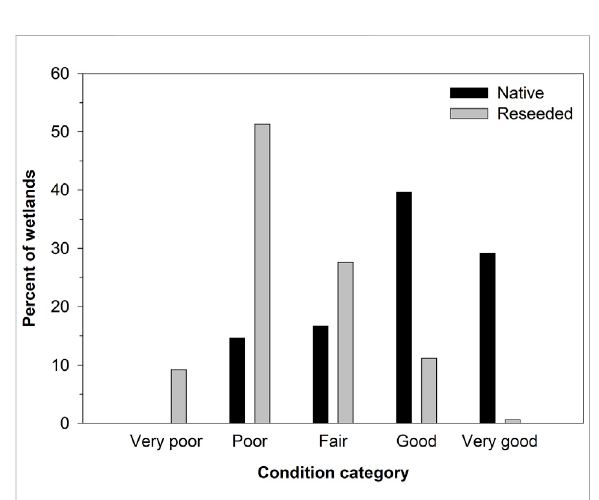
FIGURE 4 Percent of sampled (2020 – 2021) wetlands within 48 native prairieand152reseededgrasslandsassignedtoeachIndexofPlant Community Integrity condition category. Data represent 59 temporarily ponded and 141 seasonally ponded potholes in the United States portion of the Prairie Pothole Region of North